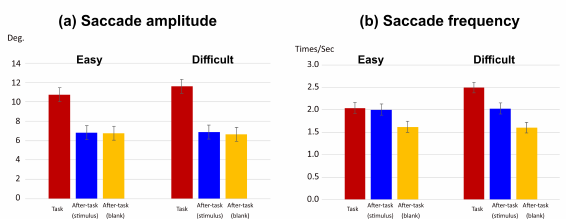
Figure-03. Effect of visual task difficulty on saccades. (a) saccade amplitude and (b) saccade frequency in task phase. Error bars in (a) and (b) indicate 95% confidential interval based on Loftus, G. R. and Masson, M. E. (1994) procedure.